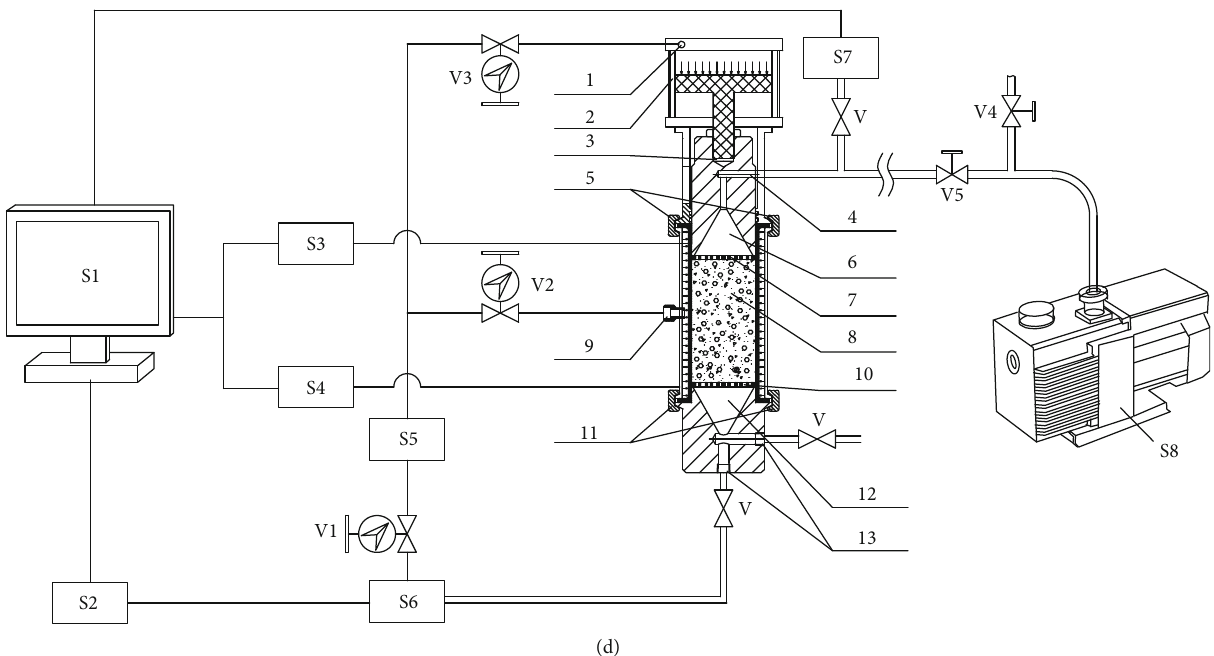
Figure 2: Experimental apparatus: (a) data acquisition system, (b) vacuum pump, (c) conveyance and fl ux control system and test cell, and (d) schematic (S1: computer; S2: servomotor; S3, S4: pressure sensor; S5: air compressor; S6: water pump; S7: measurement cell; S8: vacuum pump; V1/V2/V3: pressure-regulating valve; V4: emptying valve; V5: pump out valve; V: globe value. (1) Air inlet hole for axial pressure load; (2) air cylinder for axle load; (3) plunger of axle load; (4)/(13) water inlet (outlet); (5), (11) clamp; (6), (12) cone shape press ram; (7), (10) porous plate; (8) sample; (9.) air inlet hole for con fi ning pressure